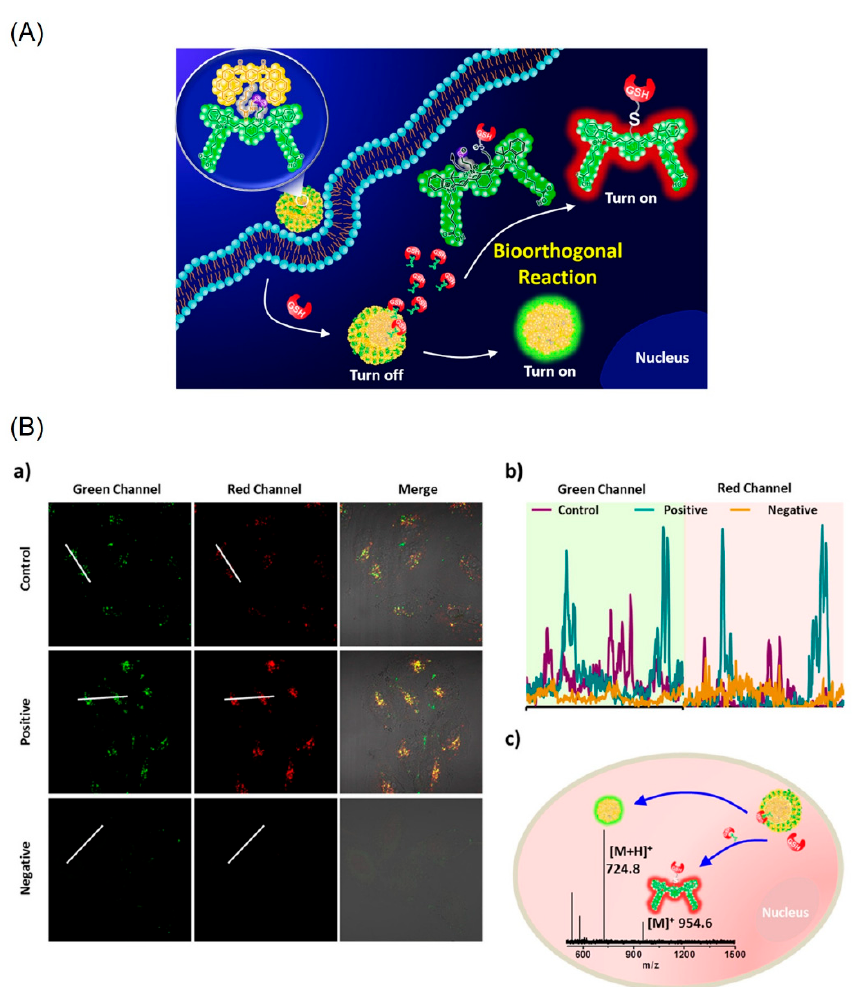
Figure 6. ( A ) Schematic illustration of a new GSH-bio-orthogonal reaction that enable to decipher the nanoemitters of cyanine-pyrene dye ( 1 ). Resulting in turn-on binary fluorescence signals with a large shift excitation/emission profiles in living systems. ( B ) GSH-based bio-orthogonal reaction for intracellular application. ( a ) CLSM images of the nanoemitters 1 (30 µ M) in MCF-7 cells (control), LPA (a lipoic acid, a GSH enhancer) pretreated cells (1.8 mM, 24 h, positive) and NEM (N-ethylmalemide a GSH scavenger) treated cells (500 µ M, 2 h, negative). ( b ) Representative line plot of MCF-7 cells and the corresponding fluorescence signal distribution based on the white line in images. ( c ) The MALDI-TOF spectrum of MCF-7 cell lysates after incubation with the nanoemitters 1 (50 µ M) for 3 h (Reproduced with the permission from Ref. [73]).